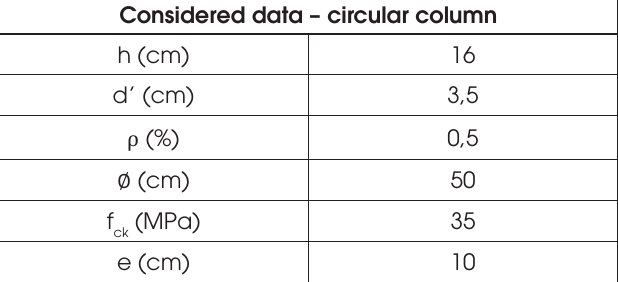
Considered data in the models for circular column